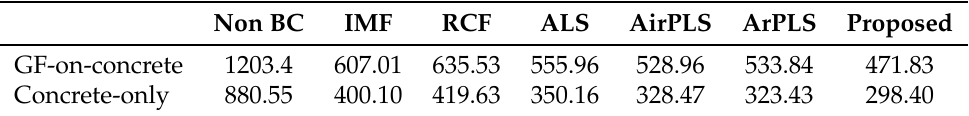
Table 2. RMSME averages of 500 GF-on-concrete spectra and 1000 concrete-only spectra for baseline correction